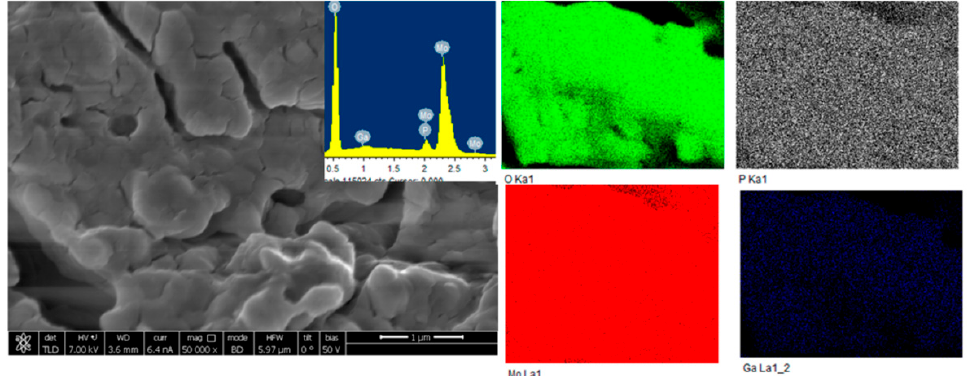
Figure 7. SEM image of Ga salt of molybdophosphoric acid (GaHPMo) with the EDS plot and elemental mapping. Adapted with permission from ACS [64].